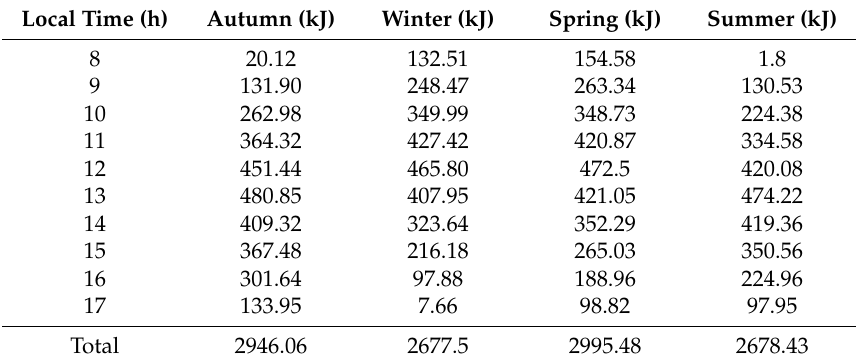
Table 4. Energy availability on static setup receiver (21 ◦ ) for annual